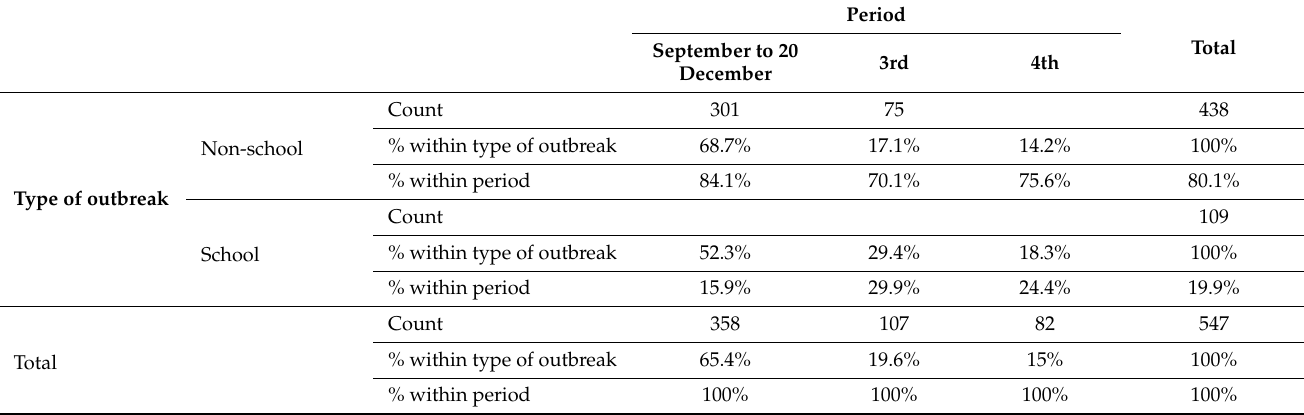
Table 3. Relationship between type of outbreaks and periods (own elaboration). p = 0.004.